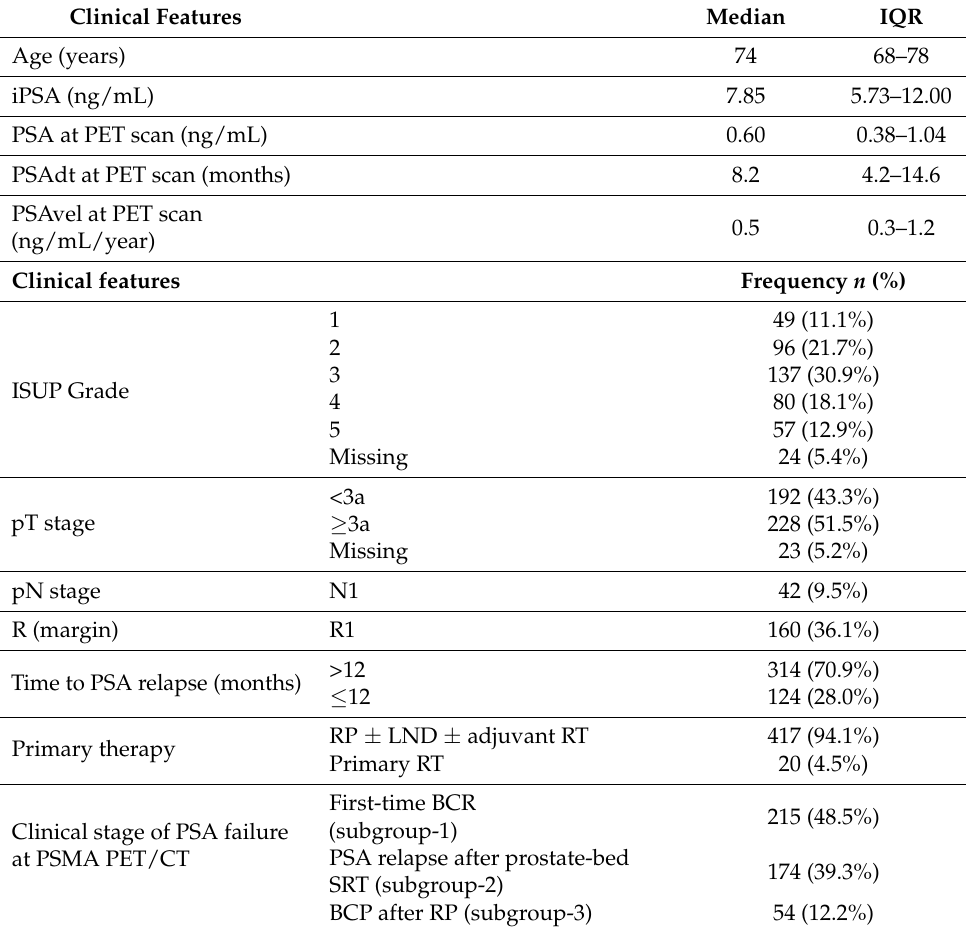
Table 1. Cohort characteristics (retrospective analysis of 443 68 Ga-PSMA-11 PET/CT